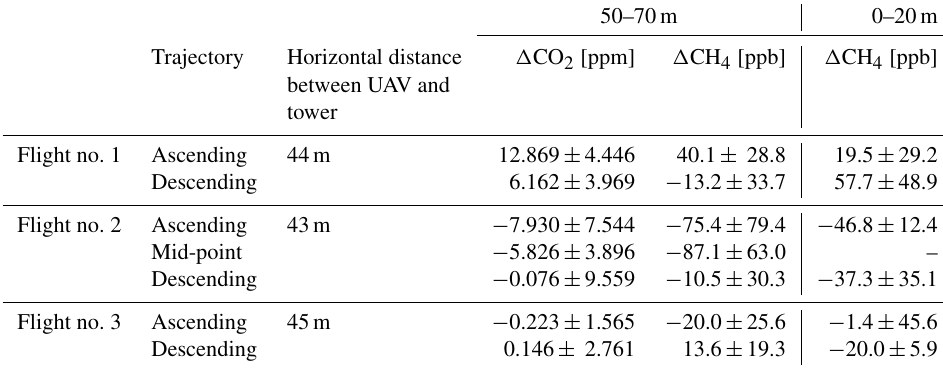
Table 4. The differences between the measured active AirCore profiles and the trace gas mole fractions measured at the atmospheric station at 60 and 7m. An average mole fraction from the AirCore profile between 50 and 70m is compared to an average mole fraction of the 60m tower measurements within the same time frame. Similarly, the average mole fraction from the AirCore profile between 0 and 20m is compared to average a mole fraction of the 7m tower measurements within the same time